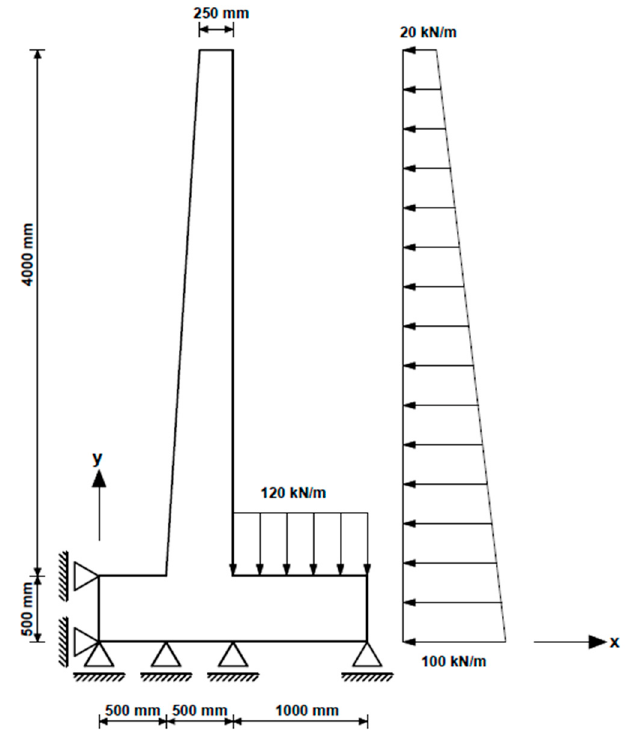
Figure 6. Cantilever retaining wall as Structure 2.